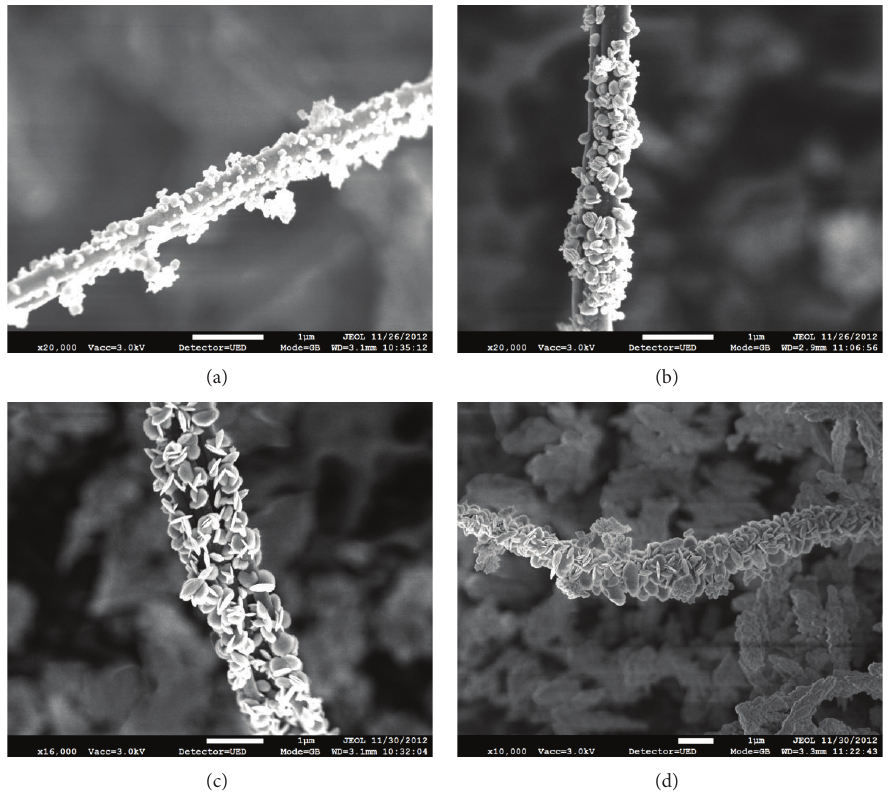
Figure 4: SEM images of as-obtained Fe 2 O 3 -CNFs as the function of pH value: (a) 2.0, (b) 3.5, (c) 4.5, and (d) 6.0.